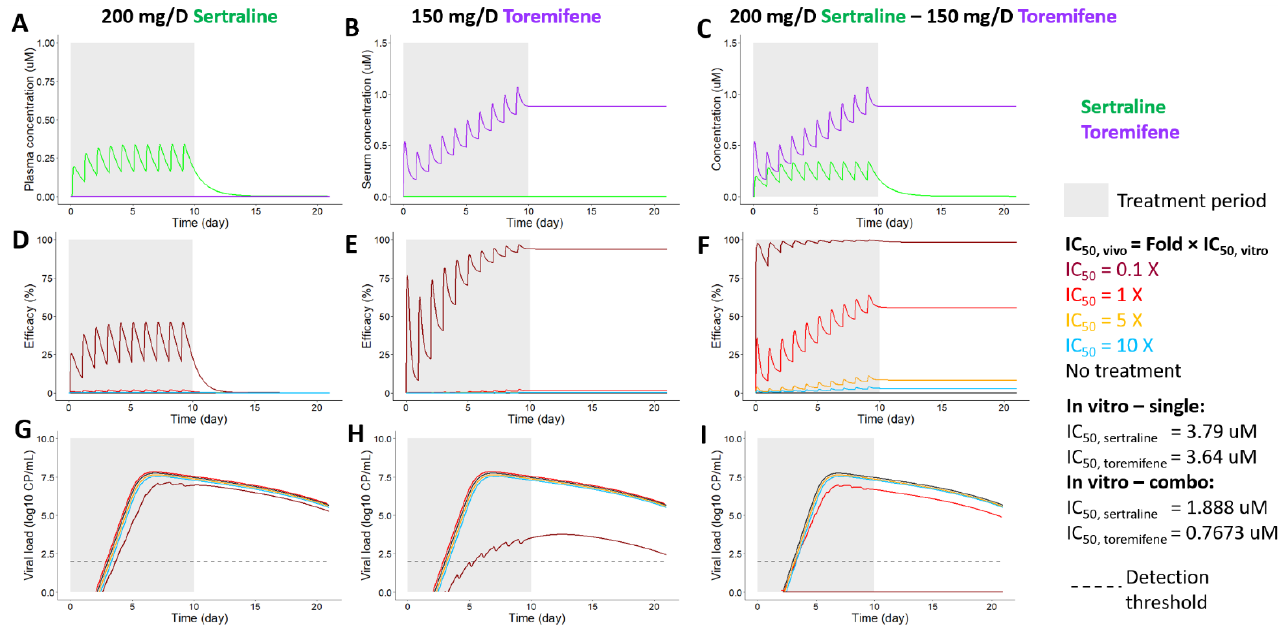
Figure 8. Projections of pharmacokinetics (PK), pharmacodynamics (PD), and EBOV viral dynamics when sertraline and toremifene are used alone and together. Treatment periods start on day 0 and end on day 10, as indicated with gray backgrounds. Doses are 200 mg/day for the single sertraline treatment ( A , D , G ), 150 mg/day with a loading dose of 300 mg/day (on day 0) for the single toremifene treatment ( B , E , H ), and 200 mg/day sertraline—150 mg/day toremifene with a loading dose of 300 mg/day (on day 0) for the treatment of the drug combination ( C , F , I ). We assumed various in vivo IC 50 s in each treatment, which are shown in colors of sky blue for 10 × , orange for 5 × , red for 1 × and dark red for 0.1 × of in vitro IC 50 s ( D – I ). ( A – C ) PK projections of sertraline (in green) and toremifene (in purple). ( D – F ) Projected efficacies of single sertraline, single toremifene, and their combination under assumptions of various in vivo IC 50 s. ( G – I ) Model-simulated EBOV viral load dynamics (log 10 (Cp/mL), log 10 (copy number/mL)) in different treatments: single sertraline, single toremifene and their combination, when in vivo IC 50 s were varied. In graphs G – I , in cases where curves overlap (e.g., for the 5 × and 10 × simulations of in vivo IC 50 s), the lines were shifted just enough to better visualize the predicted viral loads. Note: a straight line at zero (e.g., in panel I ) indicates a lack of detectable remaining